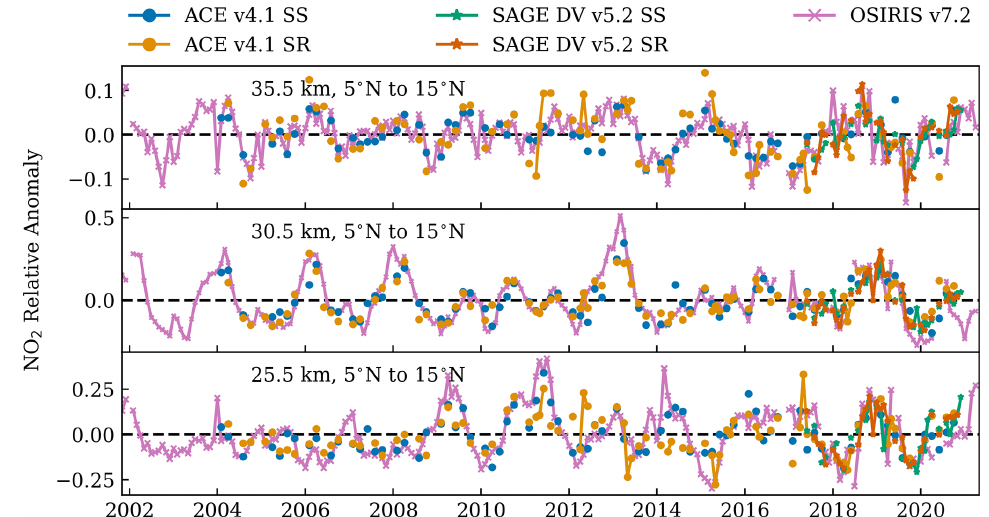
Figure A1. Anomaly time series comparing OSIRIS v7.2 to ACE v4.1 and SAGE III/ISS v5.2 DV for three altitudes in the tropics.